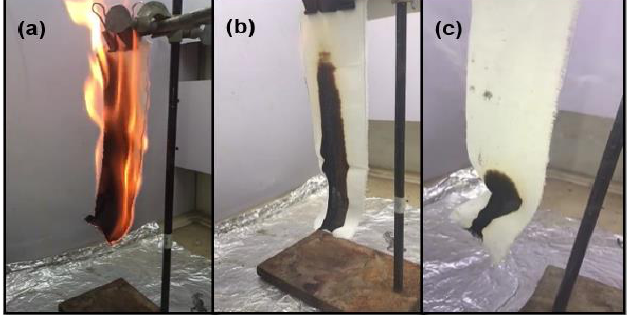
Fig. 2 . Selected sample after flammability test (a) Untreated (b) With CA, SHP and TiO2 (c) With CA, SHP and PA